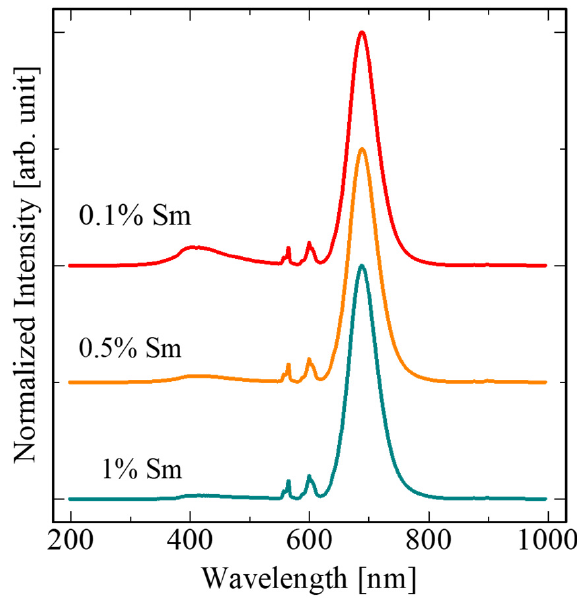
Figure 4. RL spectra of Sm:SrCl 2 .